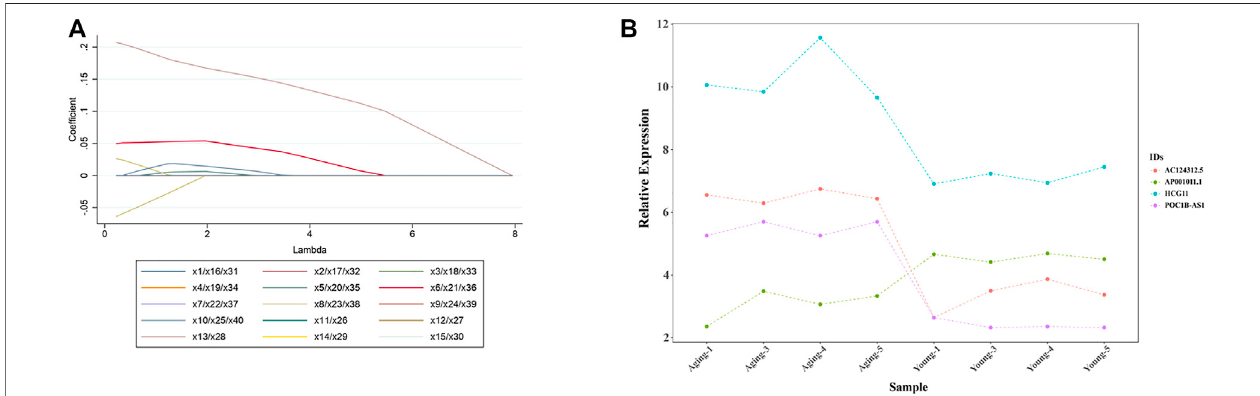
FIGURE 6 | LASSO logistic regression analysis to identify target DE lncRNAs. (A) LASSO logistic regression algorithm to screen DE LncRNAs. Different colors represent different DE LncRNAs. x1 = lncRNA AC037198.1; x2 = lncRNA AL136084.2; x3 = lncRNA JPX; x4 = lncRNA AL591895.1; x5 = lncRNA RAB30-AS1; x6 = lncRNA AC124312.5; x7 = lncRNA AP005131.6; x8 = lncRNA HCG11; x9 = lncRNA MIR99AHG; x10 = lncRNA PHIP; x11 = lncRNA HOXD11; x12 = lncRNA LOC100270746; x13 = lncRNA POC1B-AS1; x14 = lncRNA AC120036.4; x15 = lncRNA FTX; x16 = lncRNA AL118516.1; x17 = lncRNA LOC728323; x18 = lncRNALINC02062;x19=lncRNASSTR5-AS1;x20=lncRNAAC245060.5;x21=lncRNACATG00000031711.1;x22=lncRNALINC01122;x23=lncRNAG011990; x24 = lncRNA HAND2-AS1; x25 = lncRNA SNX21; x26 = lncRNA AC104389.4; x27 = lncRNA AL138733.1; x28 = lncRNA G040031; x29 = lncRNA CATG00000040688.1; x30 = lncRNA LINC01693; x31 = lncRNA G029117; x32 = lncRNA RPL34-AS1; x33 = lncRNA CATG00000059783.1; x34 = lncRNA CATG00000062802.1;x35=lncRNARBMS3;x36=lncRNAAC098818.2;x37=lncRNAAC040977.1;x38=lncRNAAP001011.1;x39=lncRNAAC012368.1;x40= lncRNA PEX5L-AS2. (B) Relative expression of 4 DE lncRNAs (lncRNA AC124312.5, lncRNA HCG11, lncRNA POC1B-AS1, and lncRNA AP001011.1) in microarray analysis. LASSO, least absolute shrinkage and selection operator; DE, differentially